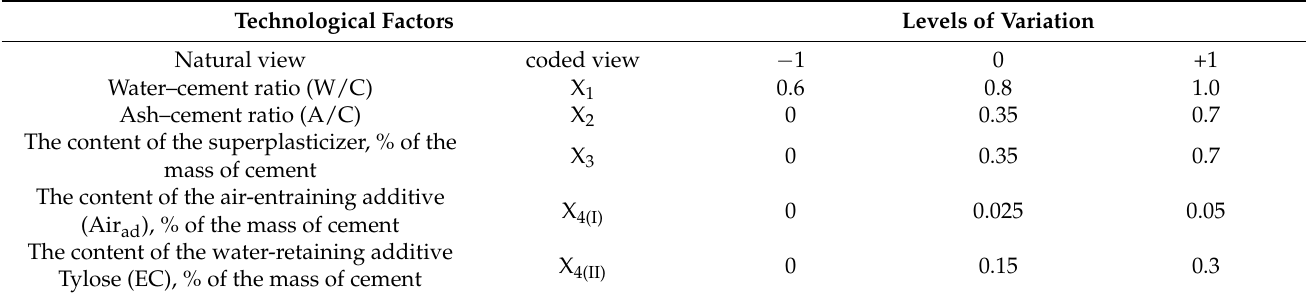
Table 4. Conditions for planning an experiment on the study of adhesion properties of modified cement–ash mortars.